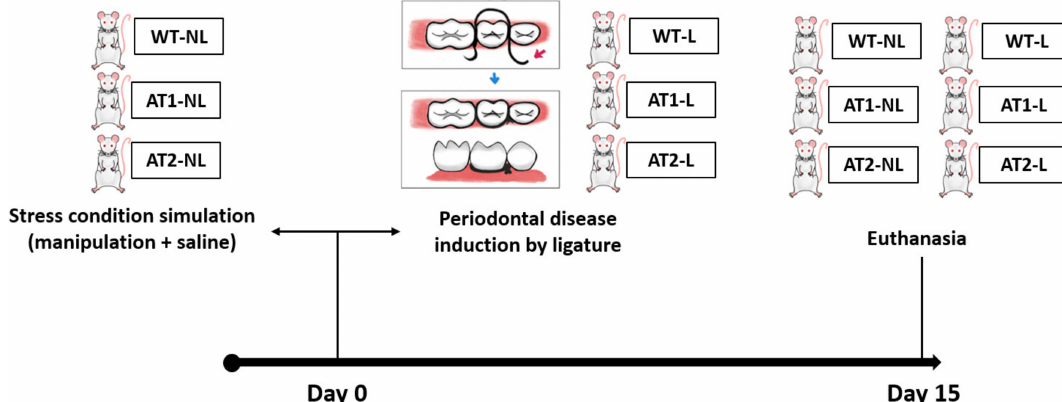
Figure 5. Design study. Wild-Type-non-ligature of periodontitis experimental model (WT-NL) and Wild-Type ligature of periodontitis experimental model (WT-L). AT1 Healthy non-ligature of periodontitis experimental model (AT1-NL) and AT1 receptor knockout ligature of periodontitis experimental model (AT1-L). AT2-non-ligature of the experimental periodontitis model (AT2-NL), and AT2 receptor knockout ligature (AT2-L) of periodontitis experimental model. Induction of periodontitis was performed in experimental groups (WT-L, AT1-L or AT2-L) by placing a 5.0 nylon thread on the mouse left second molar. Euthanasia was performed on day 15, after the gingival and maxillary tissue samples were sent for